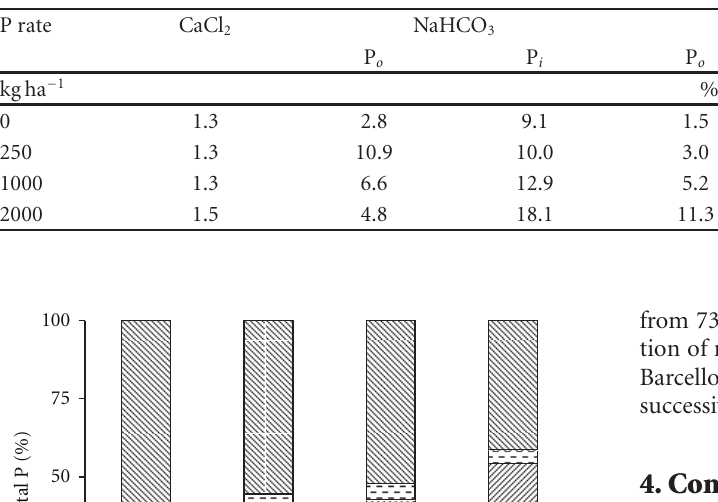
Table 5: Average proportions of P fractions in soil samples amended with increasing amounts of biosolids.